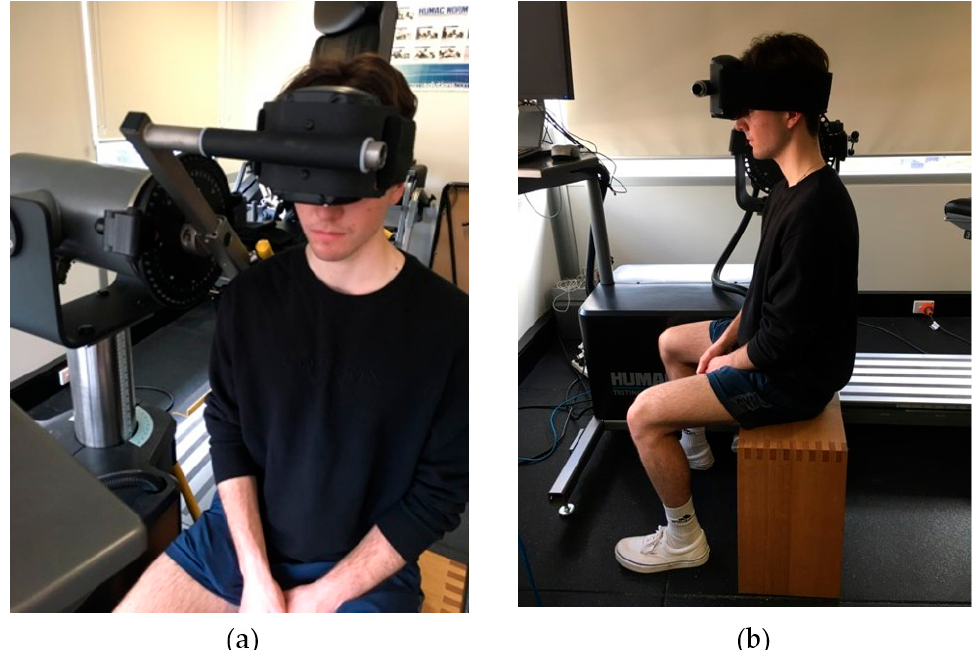
Figure 1. Set up of isokinetic dynamometer for isometric flexion and extension neck strength measurement front ( a ) and side ( b ) views.